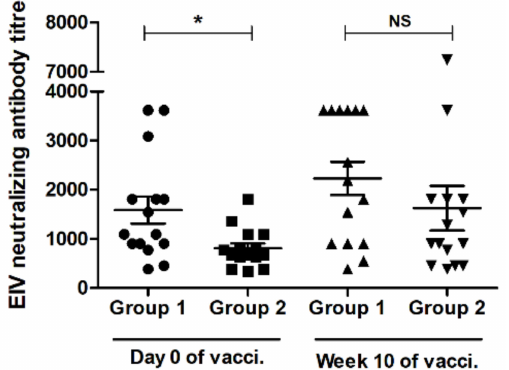
Figure 3. Mean EIV-specific serum neutralizing antibody titers determined by virus neutralization (VN) assay. Serum samples were collected from groups 1 (G1) and 2 (G2) after 6 months of im- munization (V1—day 0) with either Calvenza-03 EIV/EHV ® (group 1; G1: black circles) or Fluvac Innovator ® (group 2; G2: black squares) and after 10 weeks (V2—10 weeks) of booster immunization with Calvenza-03 EIV/EHV ® for horses of both groups (G1: upright black triangles; G2: downright black triangles), and VN assay was performed. The central line in the scattered dot plot indicates the mean of the data with standard error of mean (error bars). * A significant increase (2-way repeated measures ANOVA with Tukey’s multiple comparisons post-test; p < 0.05) of antibody titer for group 1 was seen when compared to group 2. NS—not significant; vacci.—vaccination.